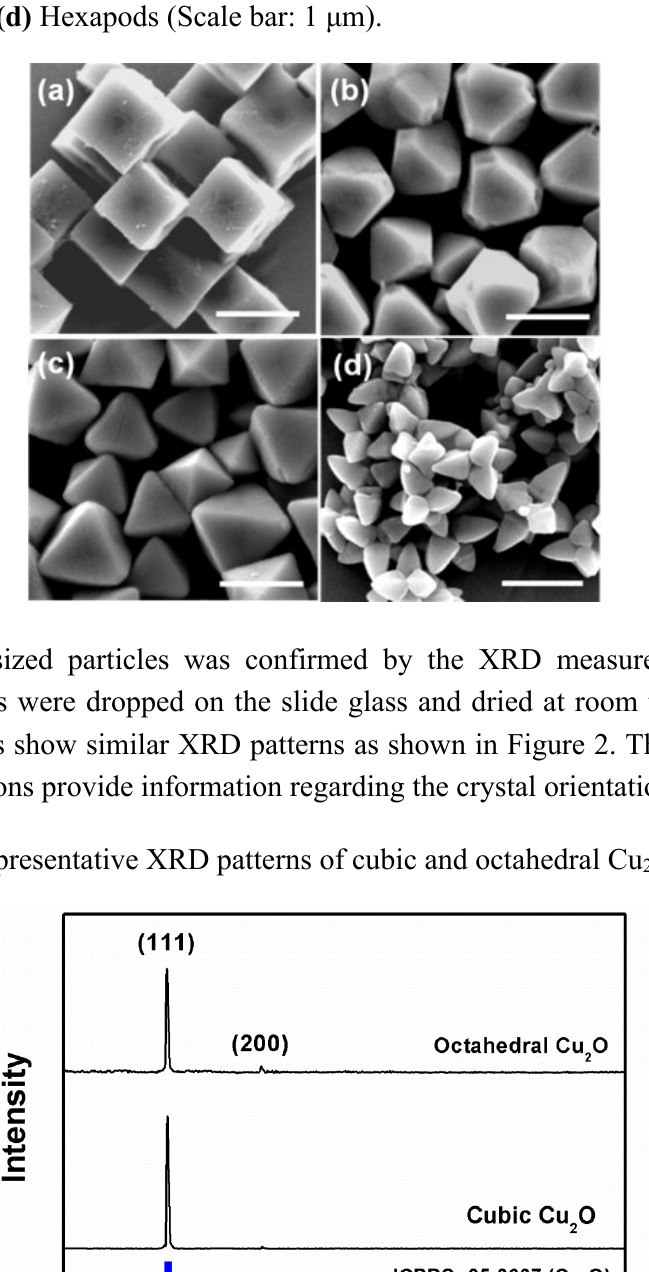
O particles ( a ) Cubes; ( b ) Truncated octahedral; 2